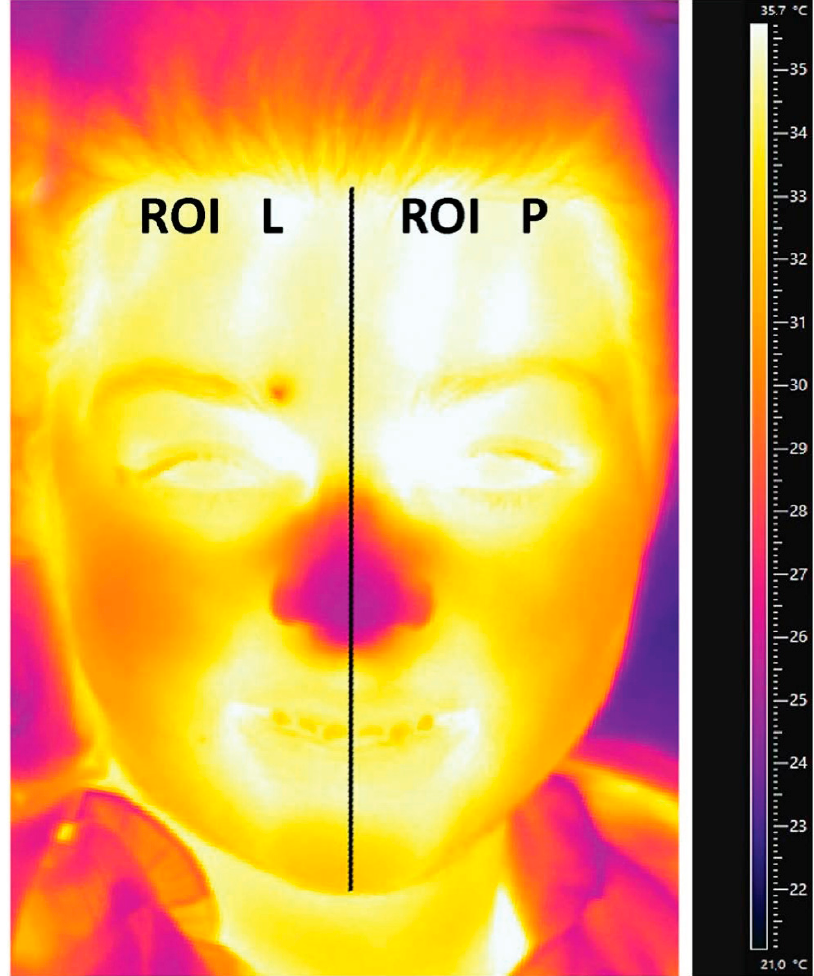
Figure 4. A thermogram of a sample patient with the left and right treatment area marked. The mean temperature difference in the ROI L and ROI R areas for all the studied patients was not statistically significant.